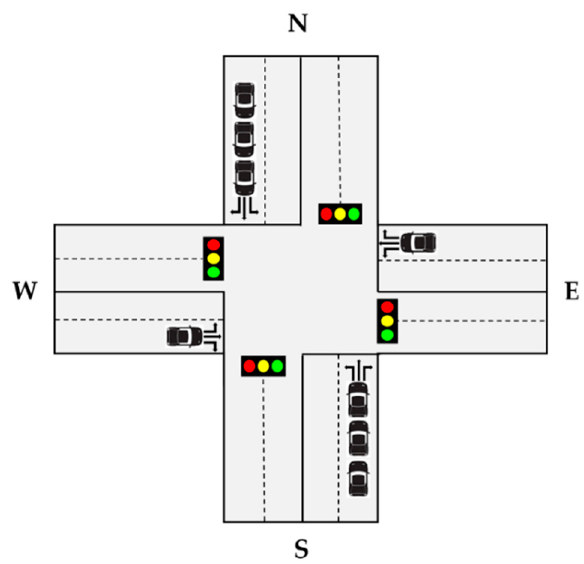
Figure 2. The 4-arm structure of intersection